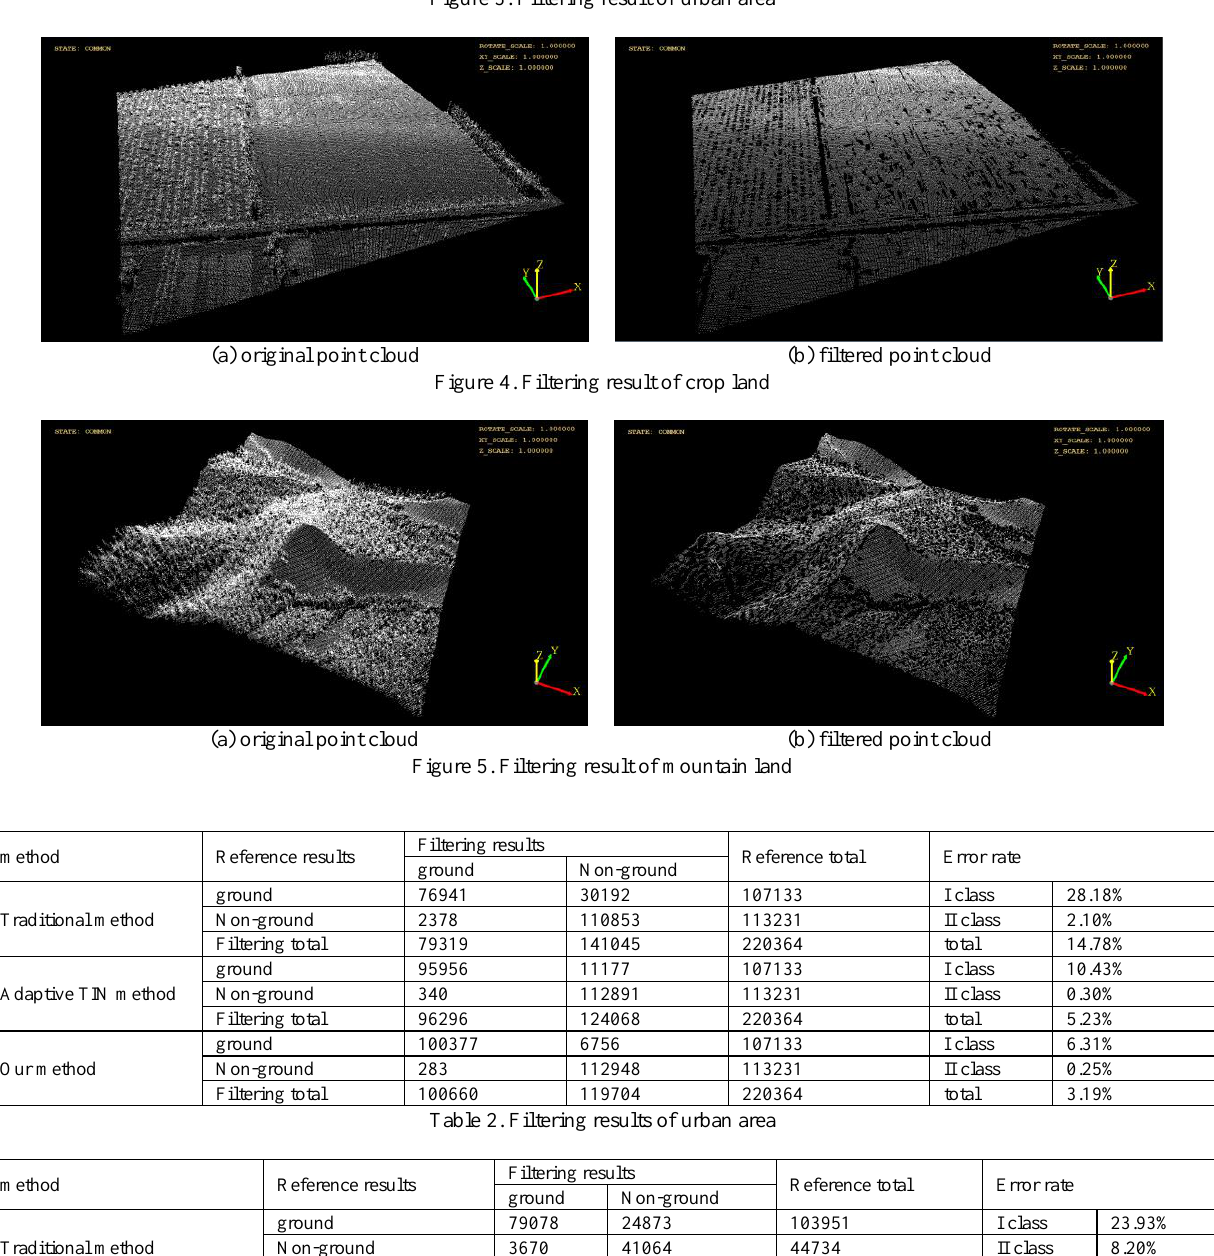
Figure 3. Filtering result of urban area